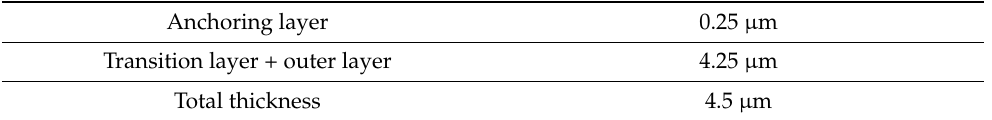
Table 1. Thickness of each layer measured by calotest.